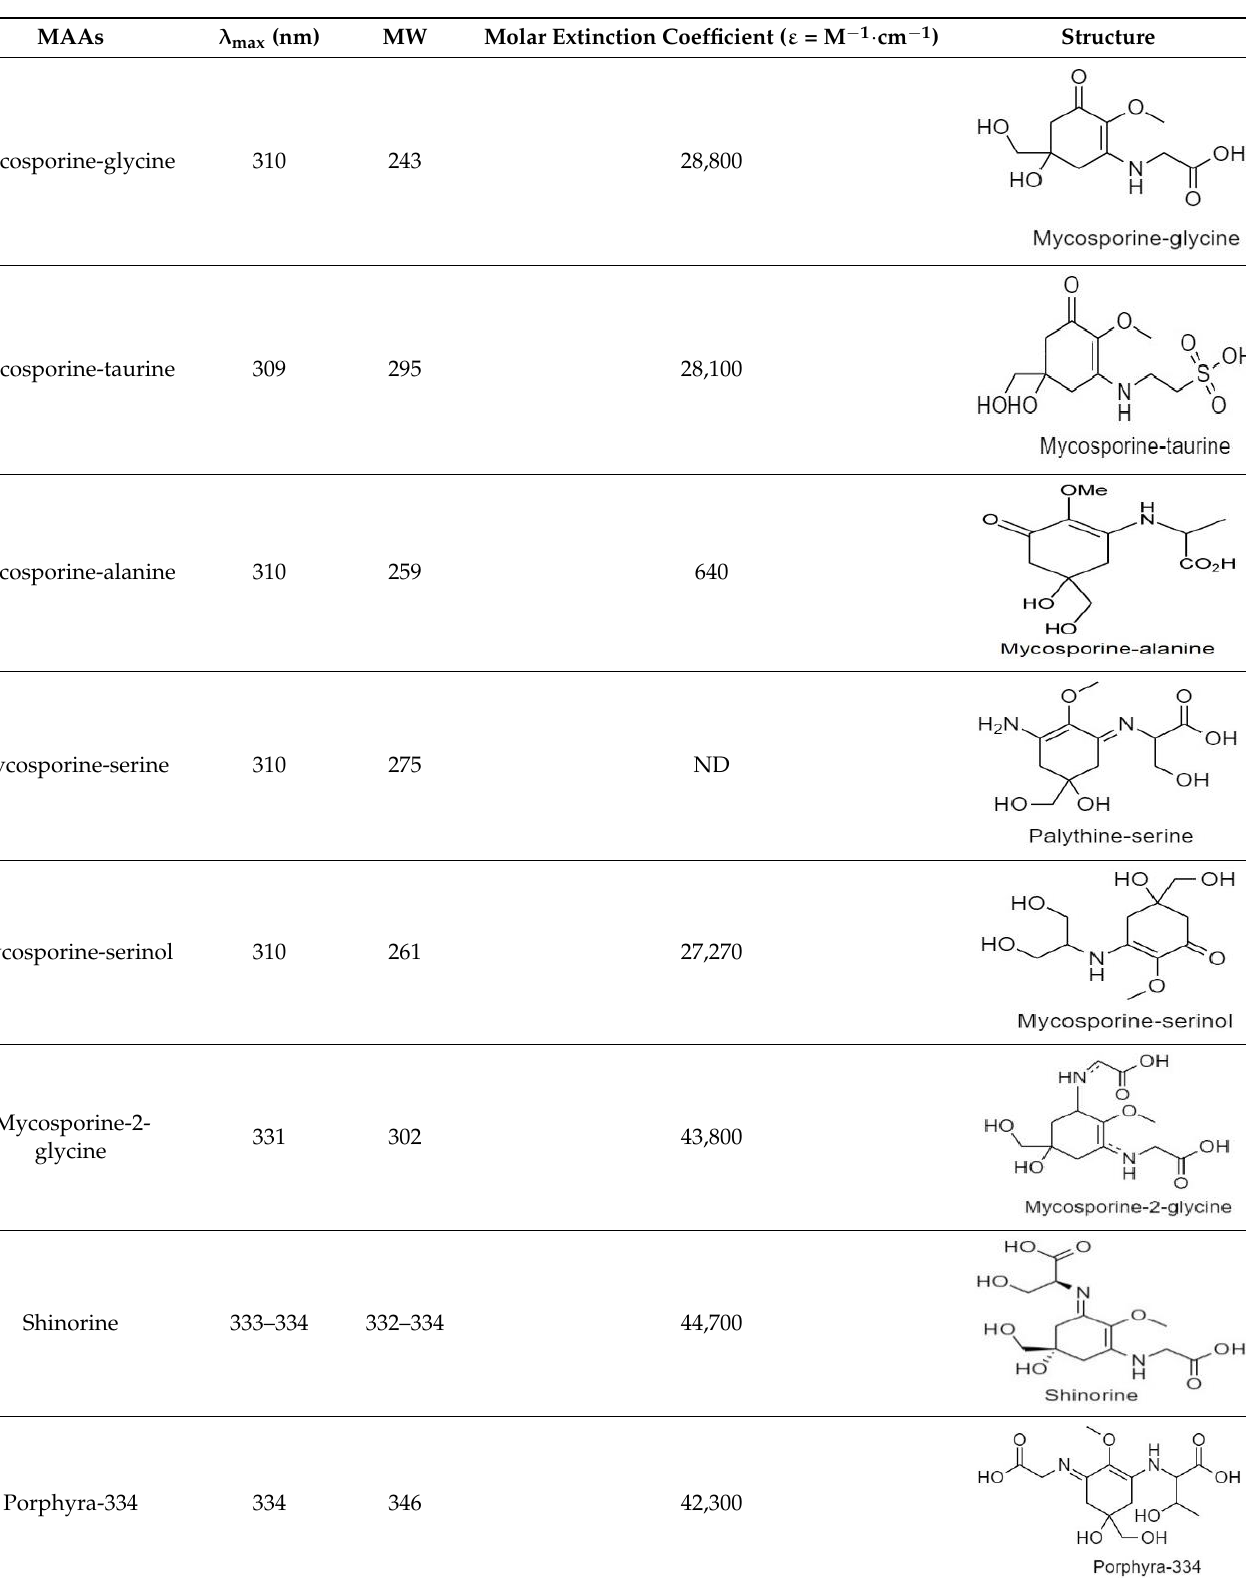
Table 1. Mono- and di-substituted MAAs with their molecular weights (MW), absorption maxima ( λ max ), molar extinction coefficients ( ε ) and structures.